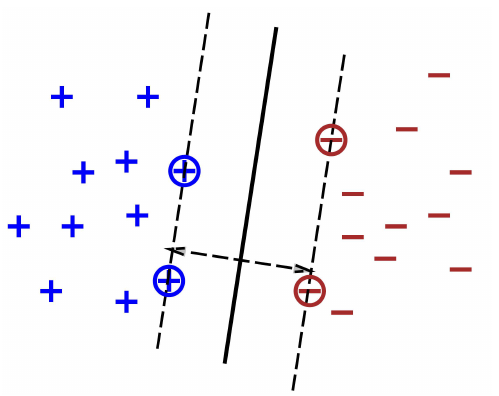
Figure 1. The optimal hyperplane that separates the positive and negative values. The position of the hyperplane is determined by the training set pairs that are closest, called the support vectors